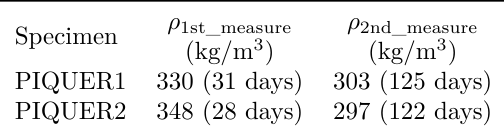
Table 2. Density of the insulation